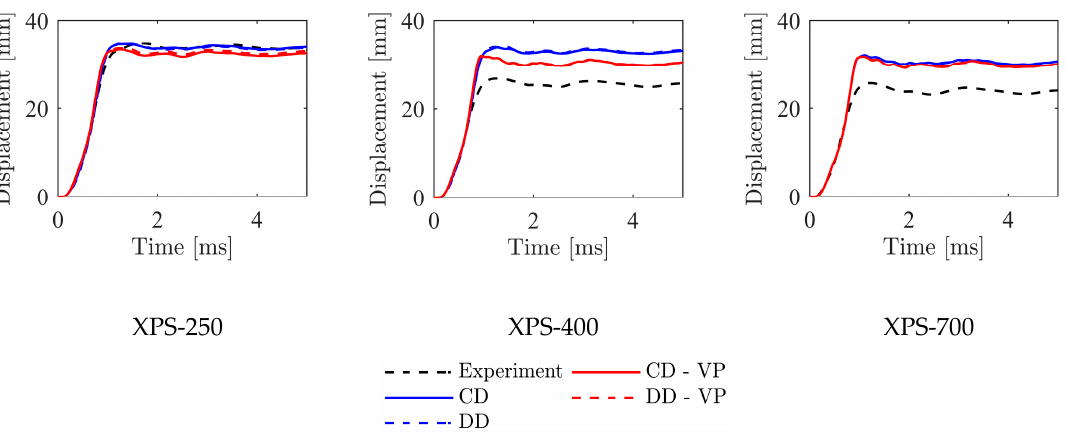
Figure 19. Back-skin displacements from simulations of tests at 10 bar driver pressure.